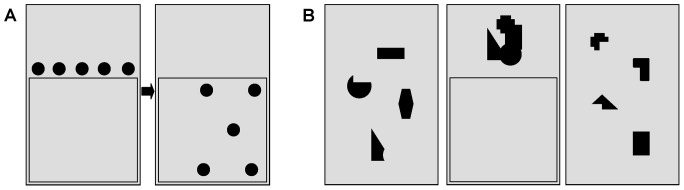
Layout of Dice Task (a) and Puzzle Test (b).In the Dice Task, patients were asked to use all dots and create a dice pattern. In the Puzzle Test, patients were required to select the correct pieces (from the left and right screen) to create the puzzle in the middle screen.